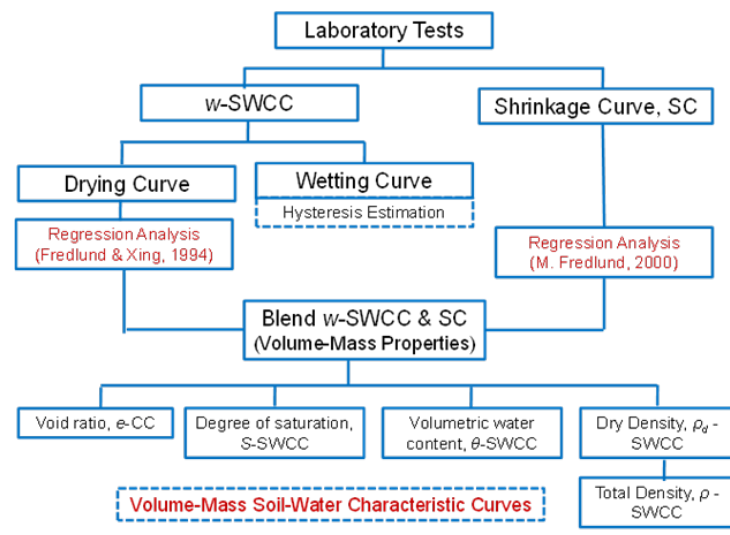
Figure 1. Steps involved in the determination of the various volume-mass soil properties versus soil suction. w-SWCC: the gravimetric water content versus soil suction test.